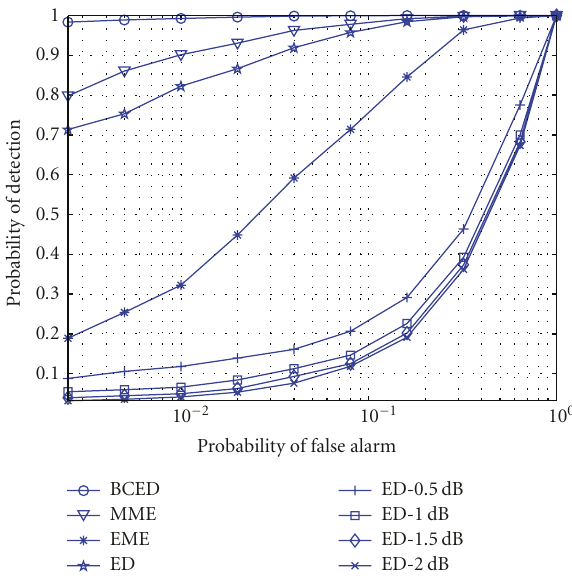
Figure 1: ROC curve: i.i.d source signal.